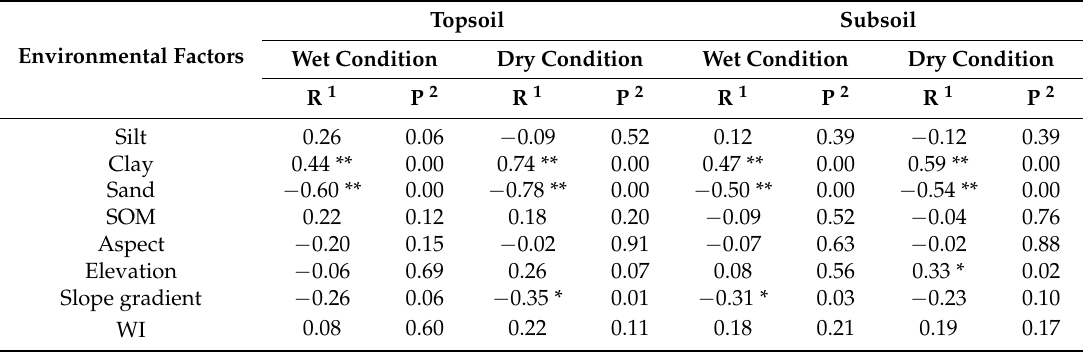
Table 3. Correlation coefficients between soil moisture content and environmental variables in top- and subsoil